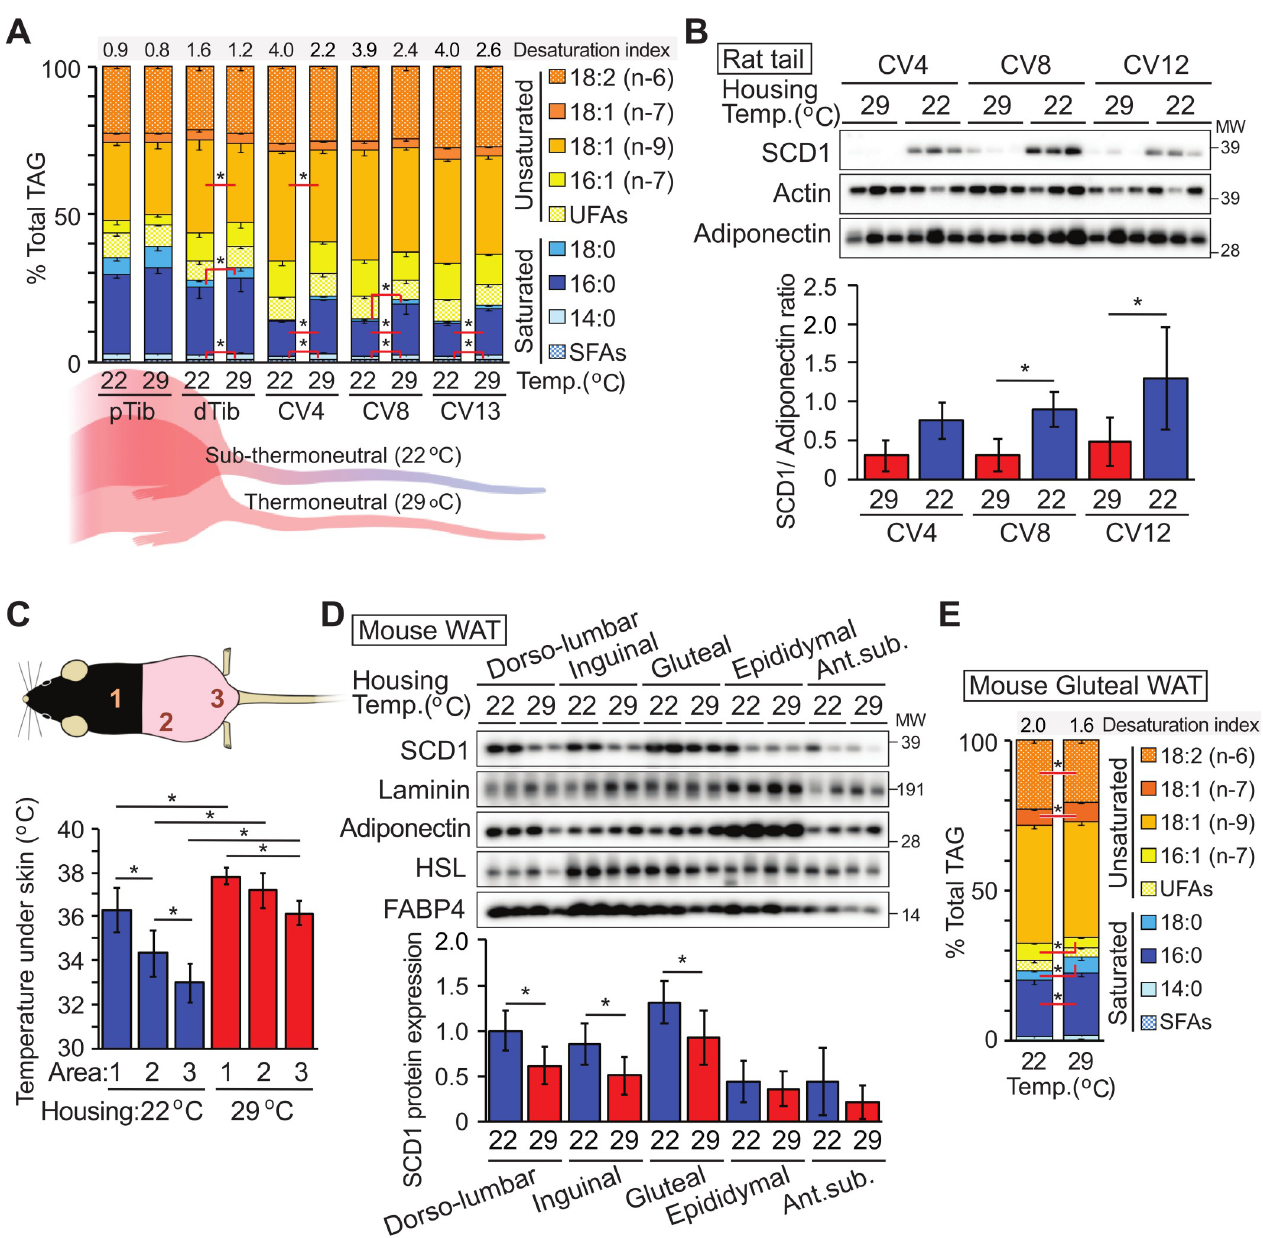
Fig 1. Lipid unsaturation and SCD1 expression are induced by cool environmental temperatures. ( A, B ) Rats were housed from birth to 11 weeks of age at standard room temperature (22˚C) or thermoneutrality (29˚C). ( A ) Increased proportion of unsaturated lipid in BMAT TAG of dTib and CV of rats housed at 22˚C. Lipid composition of TAG for pTib and dTib and indicated CV were determined by GC ( n = 6 except CV4 and CV13; n = 3). Desaturation index (16:1 + 18:1)/(16:0 + 18:0) is shown at top of graph. ( B ) Expression of SCD1 is elevated in CV from animals housed at 22˚C compared to 29˚C. SCD1 protein levels were normalized to adiponectin ( n = 7–9). ( C – E ) Mice were housed from birth to 13 weeks of age at 22˚C or 29˚C. After weaning, posterior hair was removed weekly. ( C ) The subdermal temperature of mice housed at each temperature ( n = 7, 8). ( D ) Elevated SCD1 expression in subcutaneous WAT depots of mice at 22˚C. SCD1 protein expression was normalized to geometric mean value of the following proteins; adiponectin and laminin (shown), as well as perilipin, and HSP70 ( n = 8 or 9). ( E ) Increased proportion of unsaturated lipid in TAG of gluteal WAT of mice housed at 22˚C compared to 29˚C ( n = 5). Data are presented as mean ± SD. � p < 0.05. Uncropped western blots are provided in S1 Raw Images, and numerical data for all graphs are provided in S1 Data. BMAT, bone marrow adipose tissue; CV, caudal vertebra; dTib, distal tibia; FABP4, fatty acid-binding protein 4; GC, gas chromatography; HSL, hormone- sensitive lipase; pTib, proximal tibia; SCD1, stearoyl-CoA desaturase-1; SFAs, saturated fatty acids; TAG, triacylglycerol; UFAs, unsaturated fatty acids; WAT, white adipose tissue.